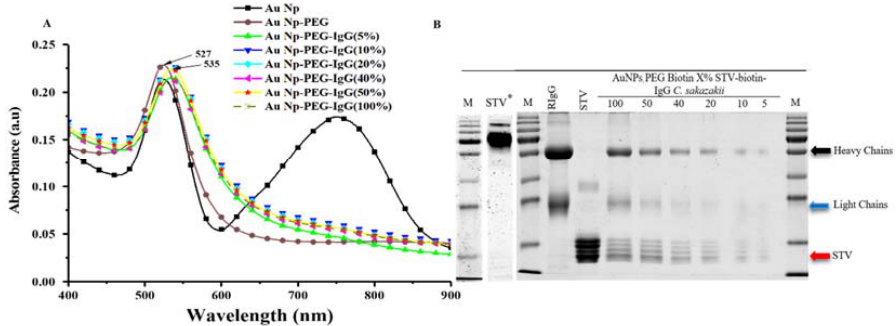
Figure 3. Characterization of optical properties and protein ‐ functionalization of Au nanoparticles grafted with HS ‐ PEG ‐ biotin. ( A ) UV ‐ Vis extinction spectra of Au ‐ core NPs grafted with PEG brushes and functionalized with different percentages of biotin end ‐ groups binding to streptavidin and further binding biotinylated anti ‐ C. sakazakii IgG suspended in 145.4 mM of NaCl; ( B ) detection of anti ‐ C. sakazakii IgG bound to Au nanoparticles functionalized with different percentages of biotin end ‐ groups and streptavidin by SDS ‐ PAGE. Two controls of streptavidin: one set was mixed with non ‐ reducing sample buffer (non ‐ denaturing) and the other was mixed with reducing agent (denaturing). M: marker, STV * : non ‐ reduced streptavidin, RIgG: standard Rabbit Immunoglobulin G from rabbit serum (commercial), STV: reduced streptavidin, black and blue arrows indicate the band of heavy and light chains of the antibody respectively; the red arrow indicates the band of streptavidin.